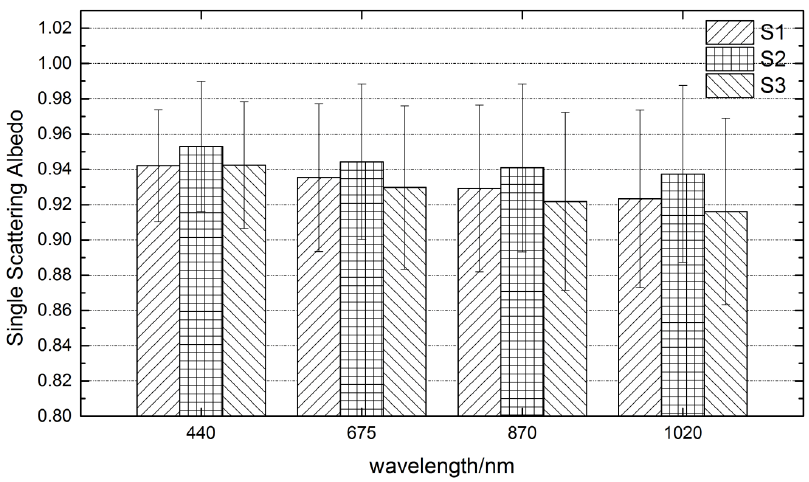
Figure 5. Variation of mean SSA at different wavelengths.